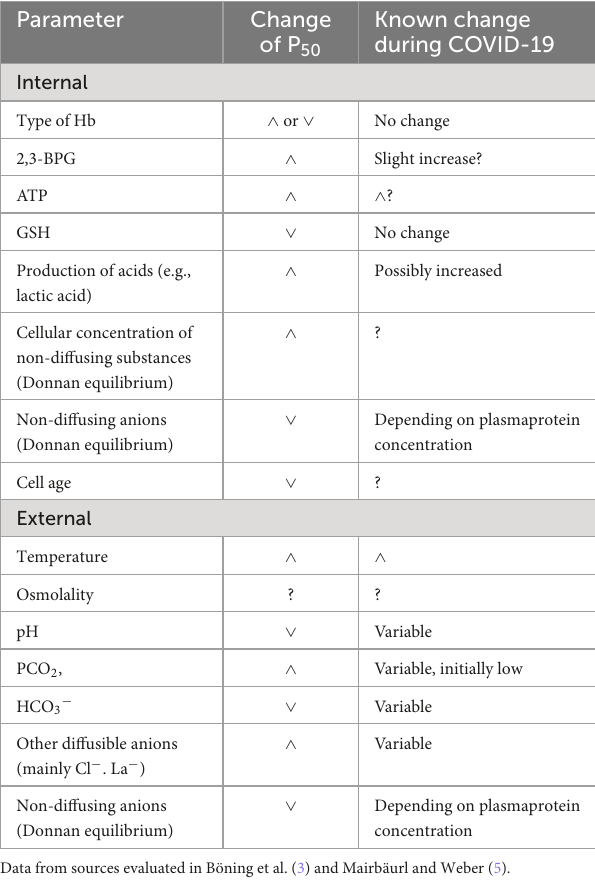
TABLE 1 Internal (erythrocytes) and external (plasma and interstitial fluid) regulators of Hb-O 2